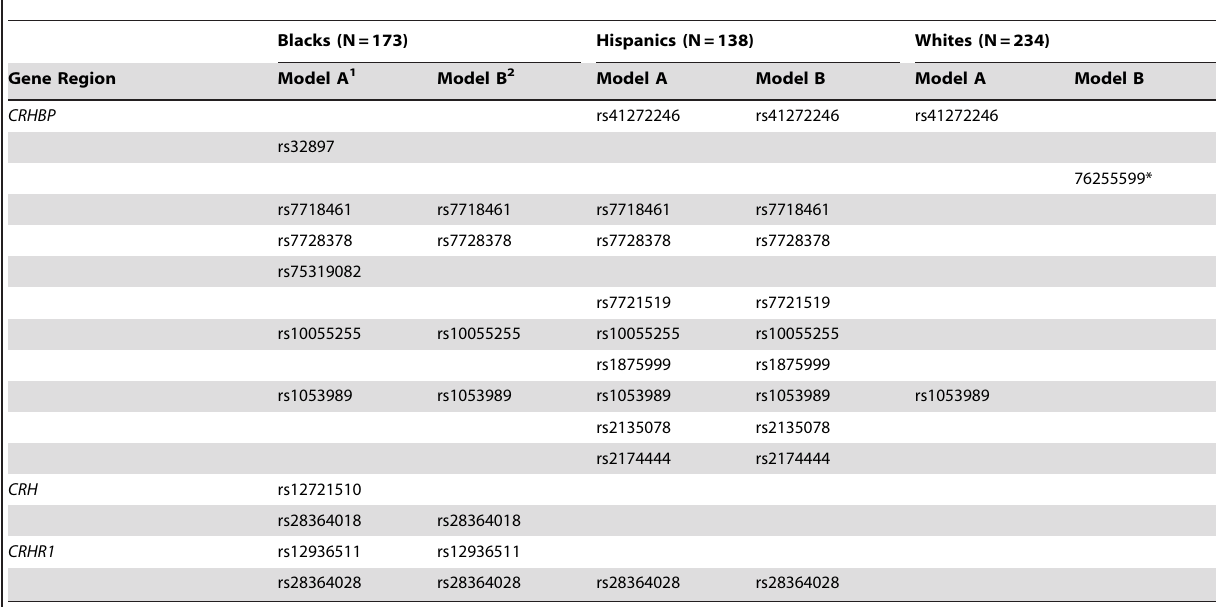
Table 4. SNPs with significant effects beyond risk factors on birth weight.